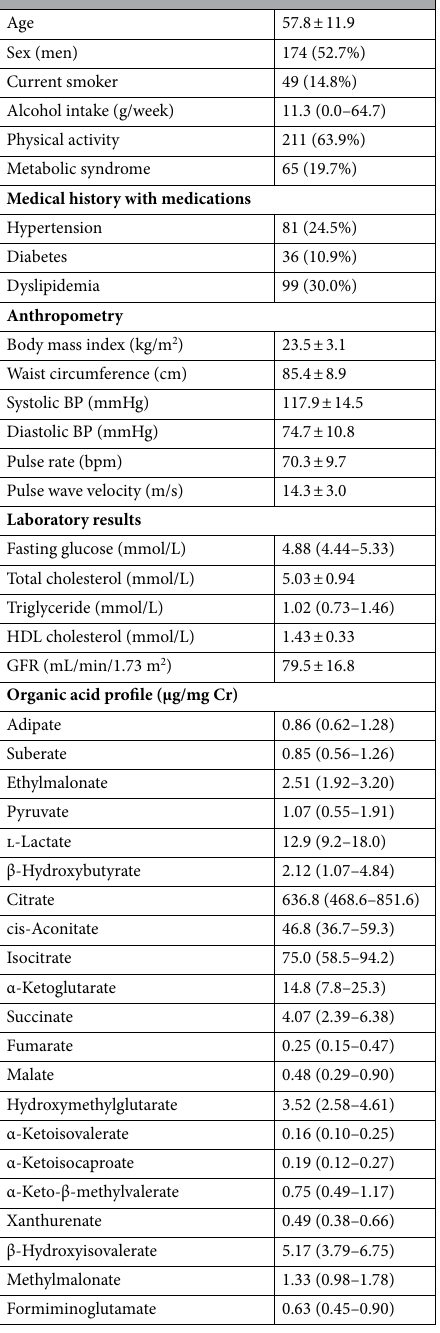
Table 1. General characteristics of the subjects. Data are expressed as mean ± SD, median (interquartile range), or number (proportion); GFR determined using the Modification of Diet in Renal Disease method.